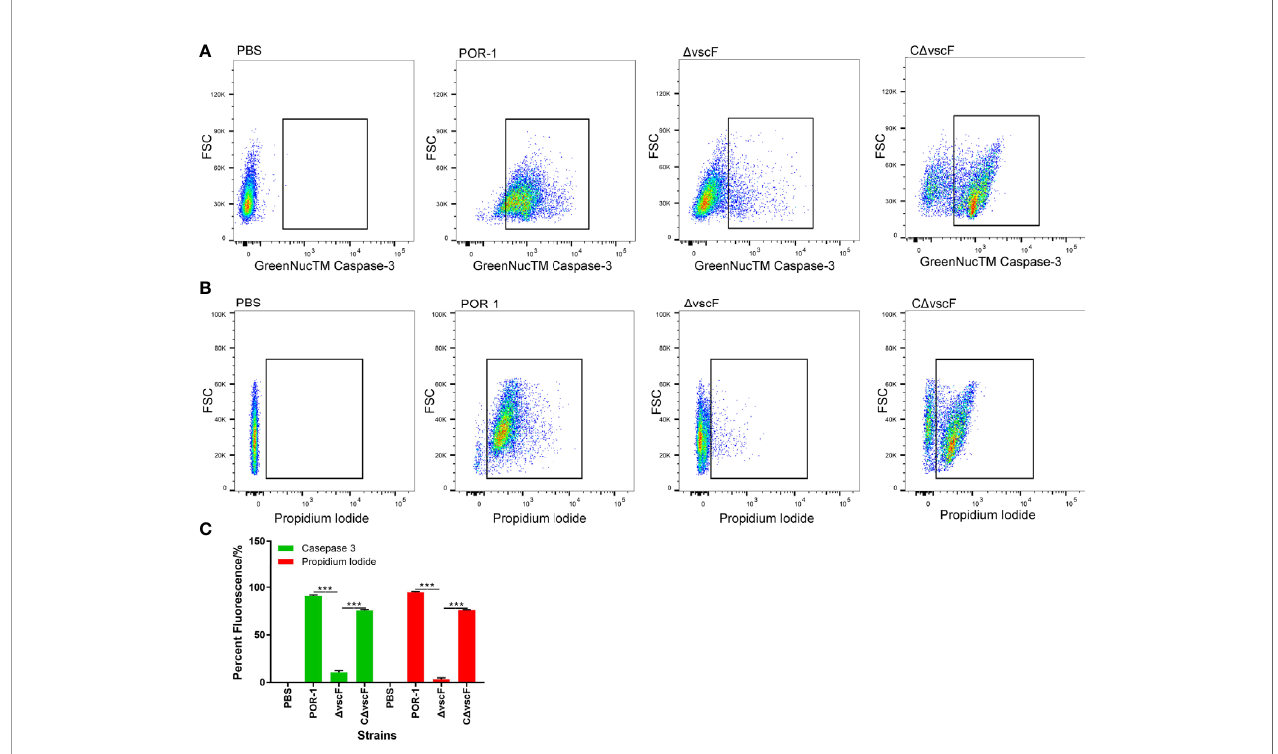
FIGURE 2 | Detection of HeLa cell apoptosis caused by V. parahaemolyticus strains using GreenNucTM Caspase-3 Assay Kit and propidium iodide. Fluorescence- activated cell sorting was used to detect fl uorescence (A, B) , and PBS was used as the blank (control). Values are the means and standard deviations from three biological replicates. Percentage represents the portion of the fl uorescently-stained cells in a total of certain number of assessed HeLa cells (C) . *** P < 0.001.